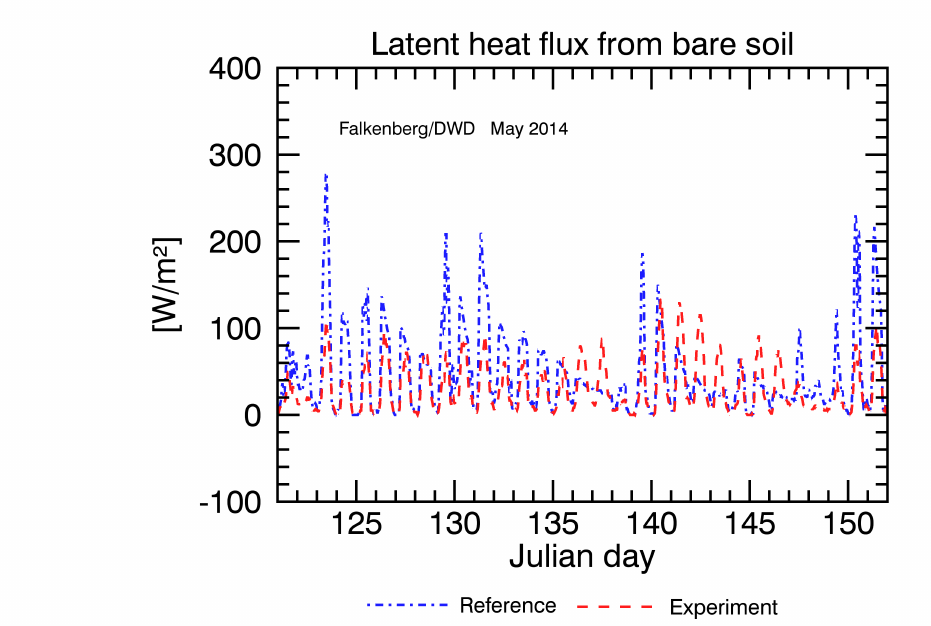
Figure 6. Same as Figure 1 but for 1–31 May 2014 (Julian day 121–151).